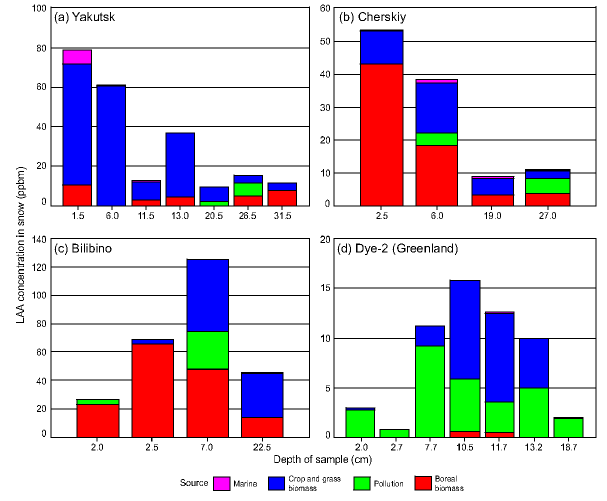
Fig. 8. Depth profile of the source contributions to LAA at sites in